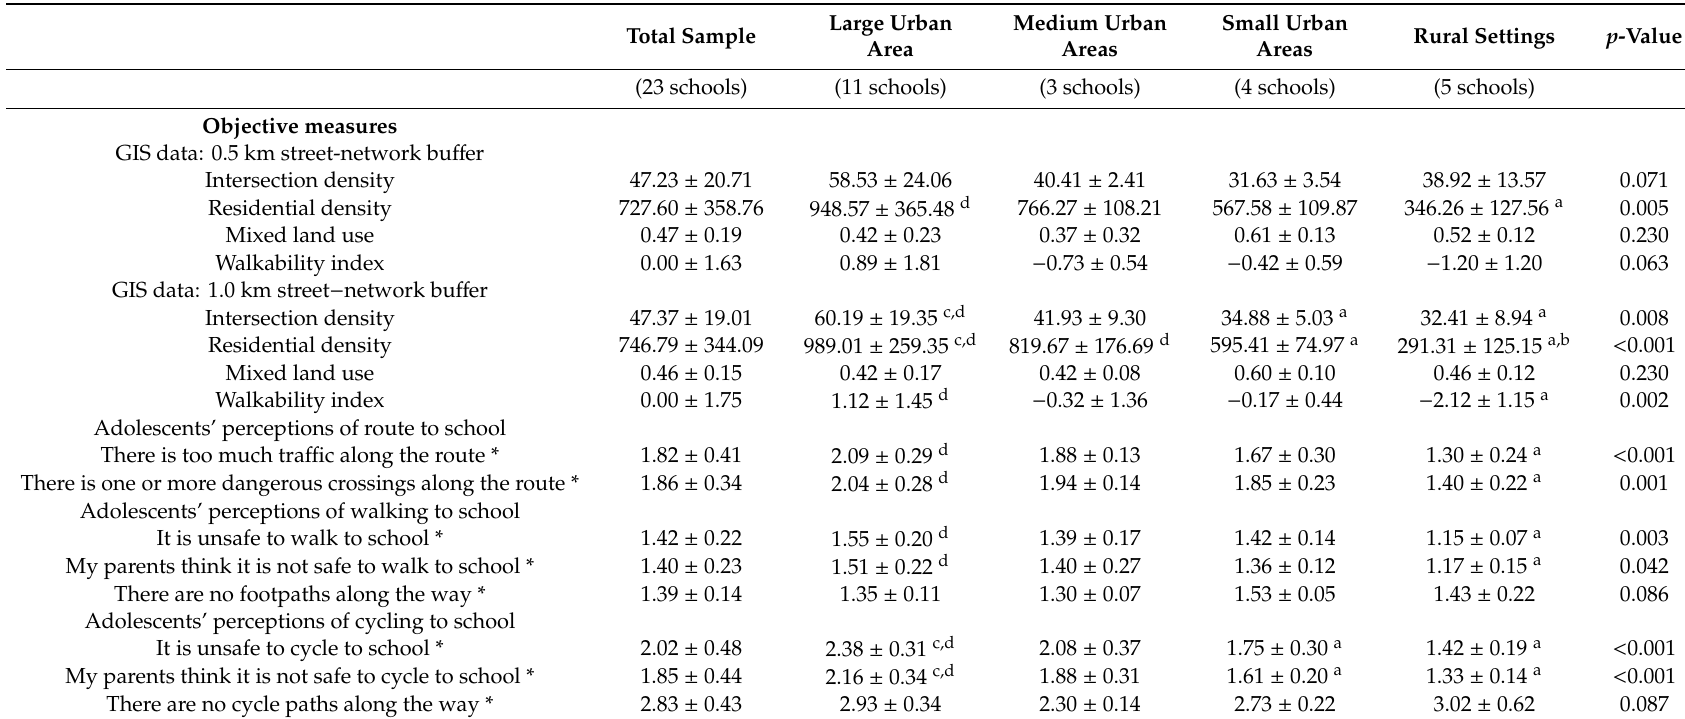
Table 3. Objectively measured and perceived built environment (BE) characteristics of the school